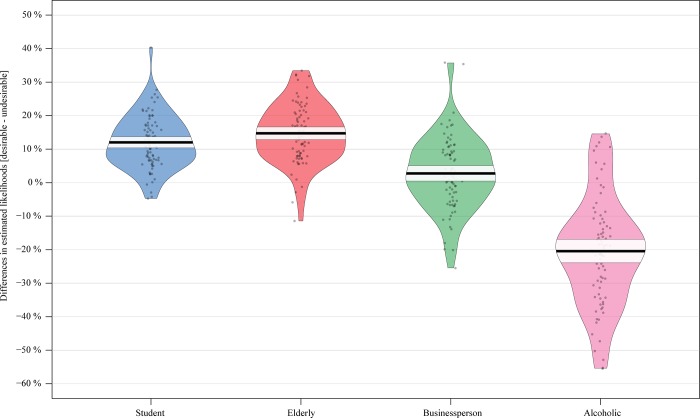
Pirate plots of the differences in likelihood estimates between desirable and undesirable events for each character.Positive values mean that desirable events are more likely than undesirable events. Dark horizontal lines reflect the sample mean. Horizontal bands around the sample mean reflect 95% confidence interval.